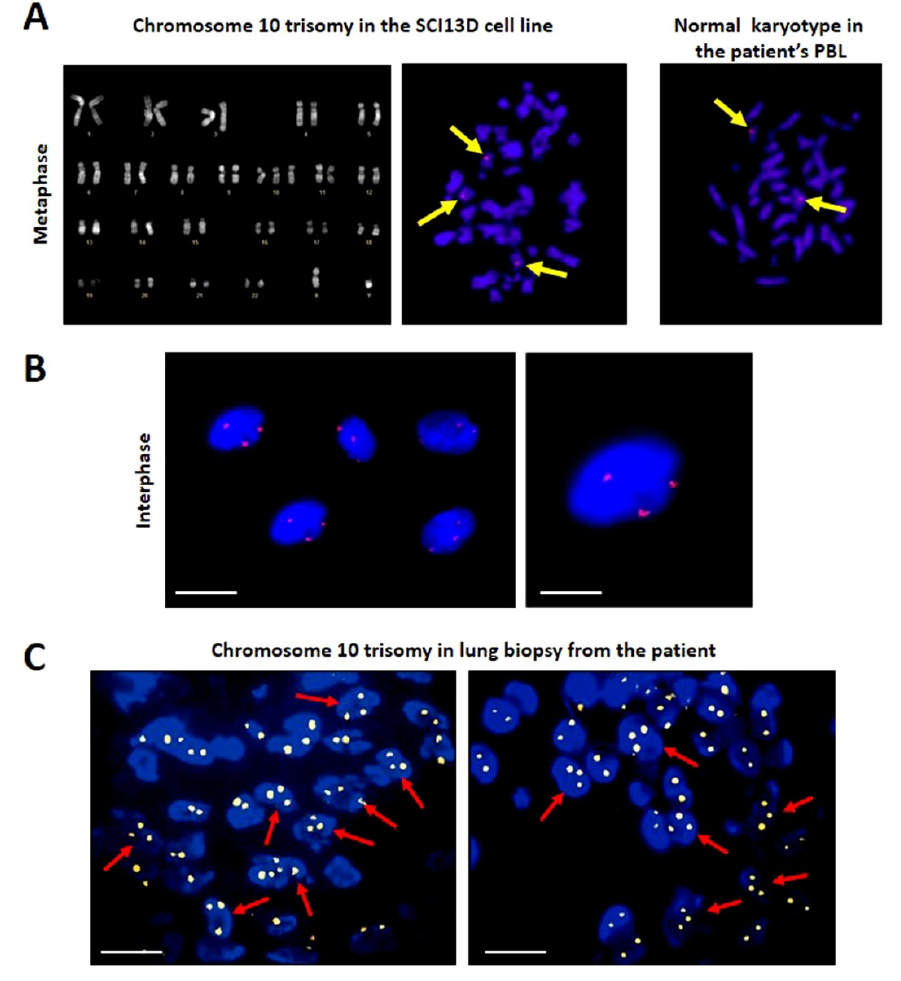
Figure 6. Karyotype of SCI13D cell line. ( A ) Analysis in metaphase of SCI13D cell line identified an aneuploid karyotype with a trisomy of chromosome 10. PBL from the same patient showed instead a normal karyotype in metaphase (100 × ); ( B ) the presence of three chromosomes 10 was further confirmed by fluorescence in situ hybridization (FISH) of the nuclei of the SCI13D cell line using a specific satellite probe for human chromosome 10; ( C ) chromosome 10 trisomy was already present in vivo in a consistent number of cells in the lung biopsy, as revealed by FISH. (scale bars in B, left panel, and C = 5 μ m; scale bar in B, right panel, = 2.5 μ m)